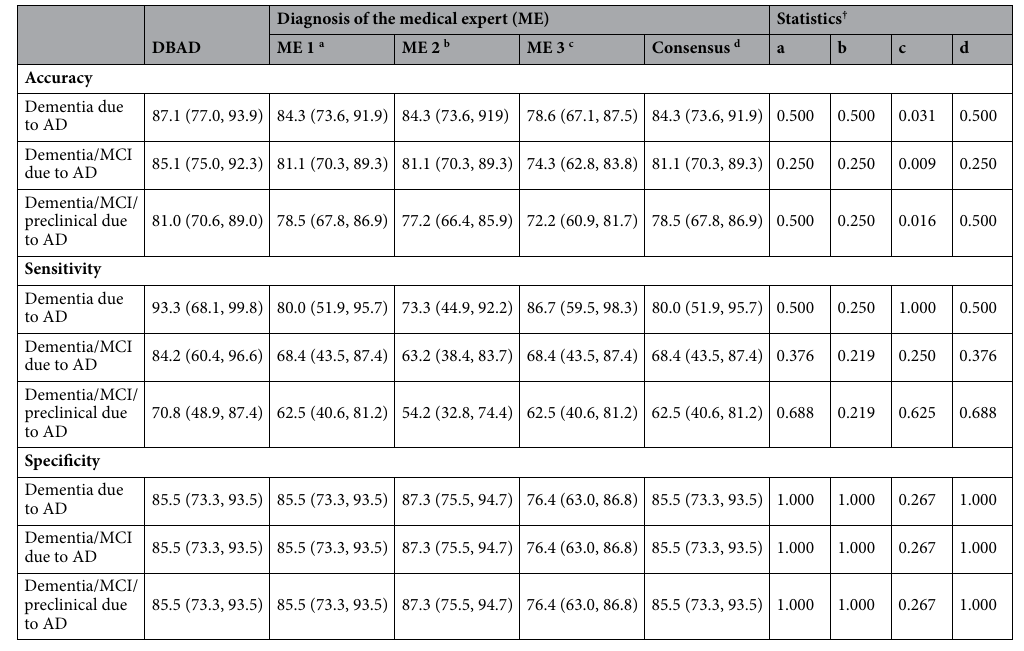
Table 3. Diagnostic performance for classifying amyloid β-positive Alzheimer’s disease from amyloid β-negative cognitively normal controls. DBAD VUNO Med-DeepBrain AD, ME Medical Expert, AD Alzheimer’s disease, MCI mild cognitive impairment. † McNemar’s test compared with the diagnosis of DBAD.